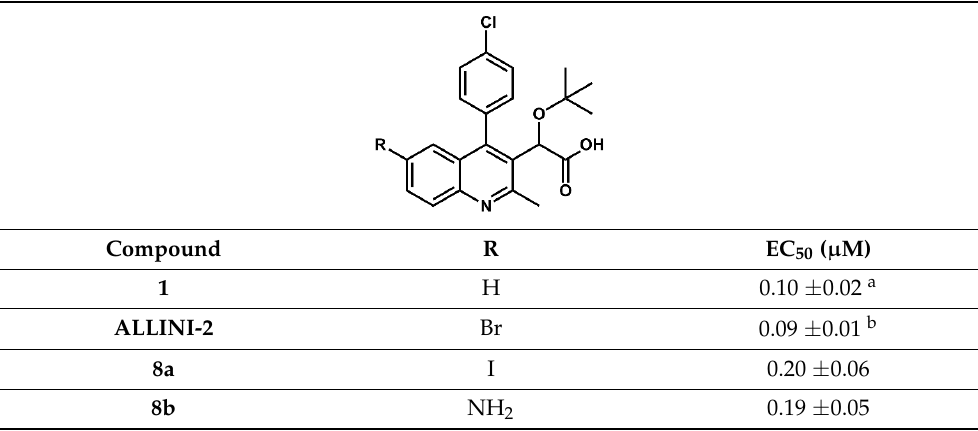
Table 1. In vitro IN multimerization EC50 activities of-substituted-4-chloroquinolines. a Data from Jentsch N. et al. (2018). b Data from Feng L. et al. (2013).